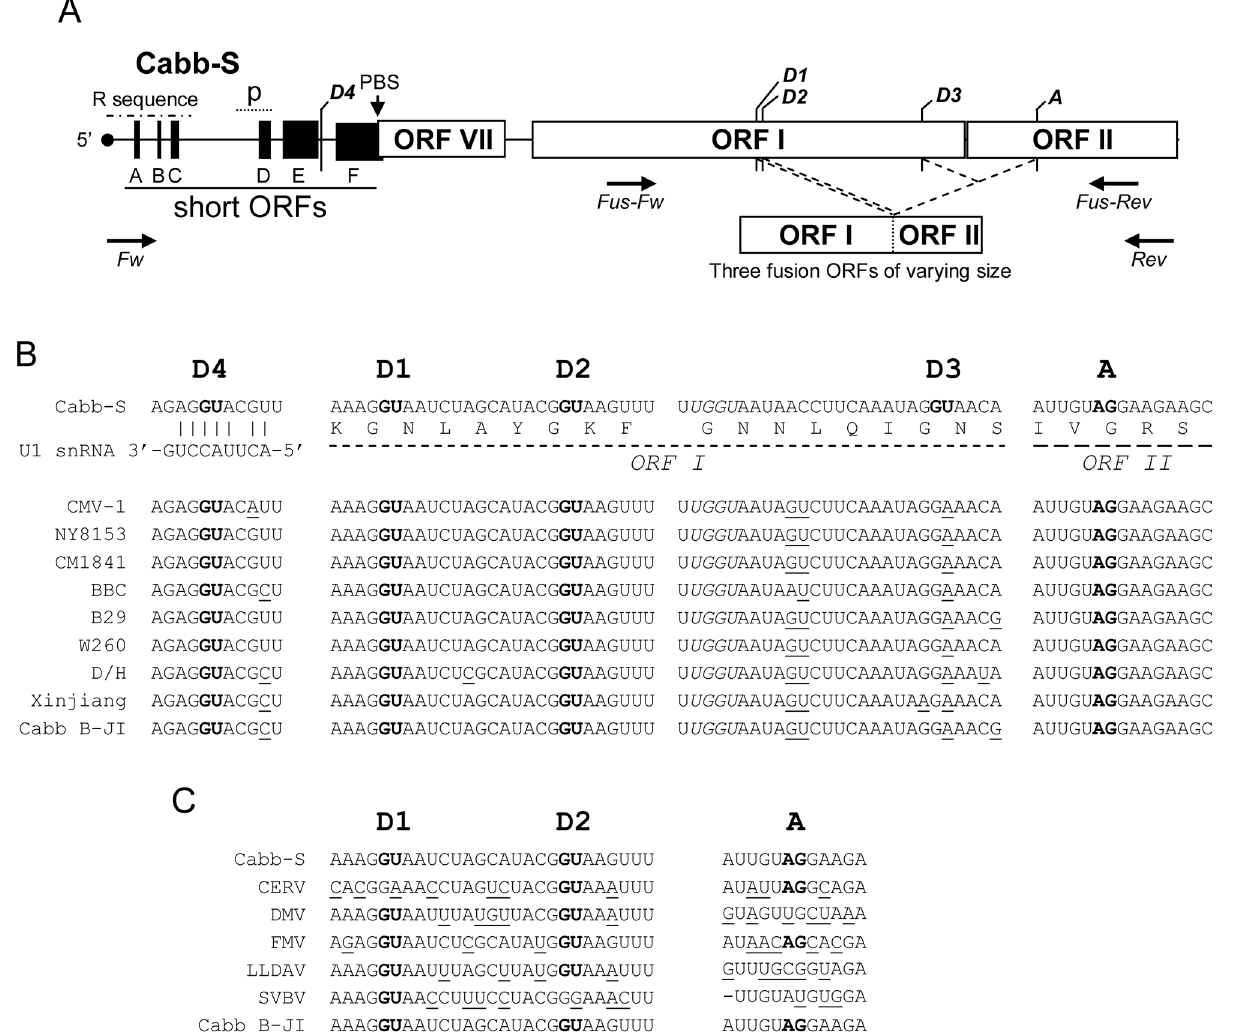
Fig 1. Conservation of 35S RNA splice sites among CaMV isolates and other Caulimoviruses . (A) Map of the 5 ’ region (about 2,500 nucleotides) of 35S RNA of Cabb-S isolate. Empty boxes represent major ORFs, while black boxes represent short ORFs (sORFs) in the leader region. D1 to D4 are the splice donor sites and A, the acceptor splice site described by Kiss-László et al . (1995). Dotted lines mark the splicing events leading to in-frame fusions between the 5 ’ and 3 ’ extremities of ORF I and ORF II, respectively. The putative encapsidation signal (p) and the primer binding site (PBS) where reverse transcription is initiated are shown. The repeated sequence R corresponds to an approximately 180 nucleotide-long sequence found in both termini of the 35S RNA. The positions of the forward (Fw) and reverse (Rev) primers used to amplify the 5 ’ part of the 35S RNA and the positions of the primers Fus-Fw and Fus-Rev used to assess the presence of P1P2 fusion protein mRNA in transient expression assays are indicated by opposite arrows. (B) Alignment of 35S RNA sequences from various CaMV isolates. The sequences surrounding Cabb-S splice sites are shown. The GU and AG nucleotides of donor and acceptor sites, respectively, are in bold. Nucleotides differing from the Cabb-S sequence are underlined. The UGGU sequence which is totally conserved among CaMV isolates is in italics. Amino acids encoded by the regions containing the spliced sites are provided below the nucleotide sequences. The interaction between U1 snRNA and the exon-intron junction is shown for D4 site. (C) Alignment of the 35S RNA sequence from Caulimovirus